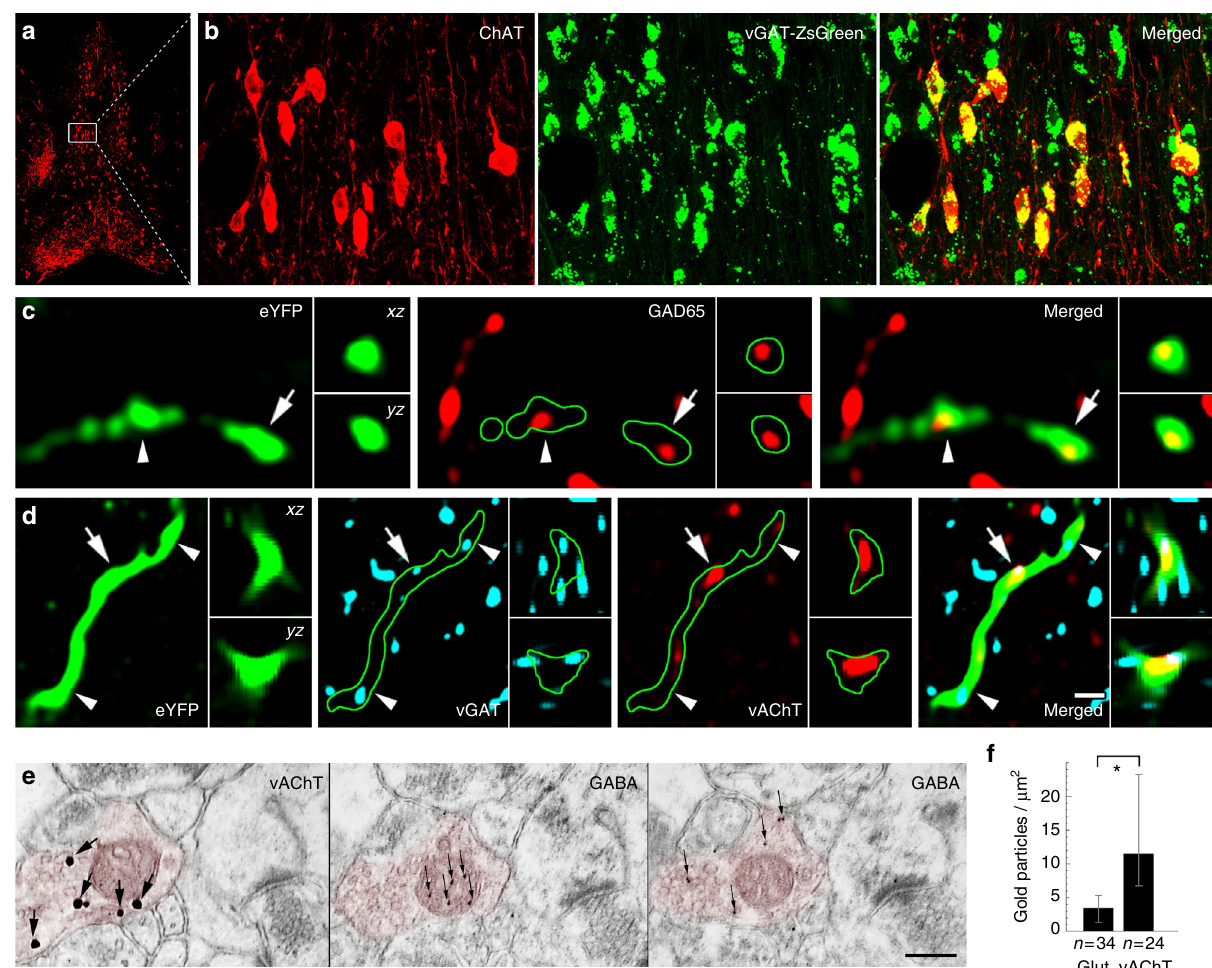
Fig. 2 Cholinergic cells express the molecular machinery required for GABA release. a , b The cholinergic neurons of the MS are GABAergic. White box in a contains area enlarged in b . Images show neurons stained for ChAT in red, while the green labelling marks the vGAT-expressing neurons in vGAT-ZsGreen reporter mouse. c , d AAV-eYFP virus-traced septo-hippocampal fi bres express GAD65 ( c ). AAV-eYFP virus-traced septo-hippocampal fi bres express vGAT and vAChT ( d ). Insets show xz and yz projections of the terminal labelled with an arrow. Arrowhead points to another terminal. Green line marks the fi bre outline. (Scale bar on d is 210, 14, 2 and 1 μ m for a , b , c and d , respectively.) e , f Hippocampal cholinergic terminals contain GABA. Three consecutive EM sections of a vAChT-positive terminal ( e , red pseudocolor) are shown. vAChT was visualised by pre-embedding immunogold method (the fi rst panel of e , silver- intensi fi ed gold particles, large arrows), whereas on the next ultrathin sections (the second and third panels of e ) postembedding GABA immunostaining was performed (smaller gold particles, thin arrows, some GABA molecules penetrate into mitochondria during fi xation). vAChT signal is absent in postembedding images, because of the etching procedure. Scale bar is 200nm for all EM images. f Cholinergic terminals contained signi fi cantly higher immunogold signal than glutamatergic ones ( p <0.05) suggesting the presence of GABA in cholinergic terminals (median and interquartile ranges, Supplementary Note